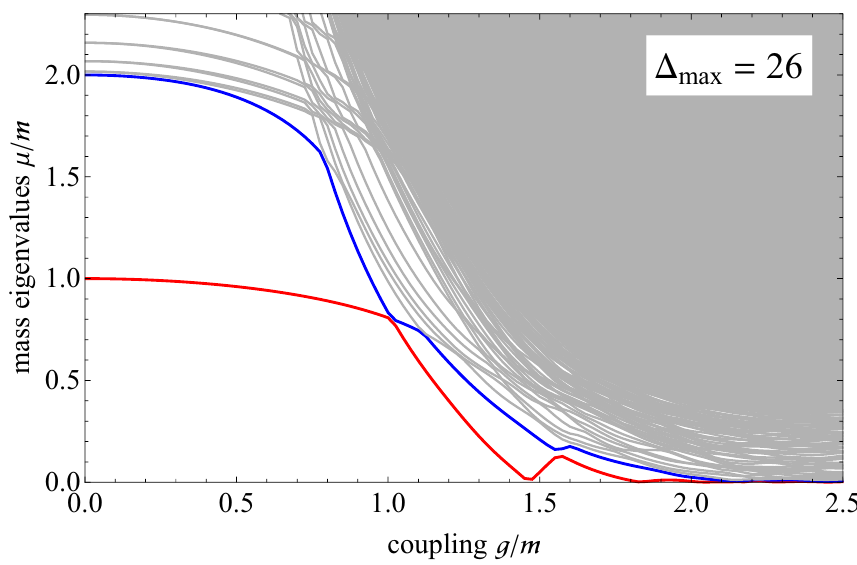
Figure 3 . Mass eigenvalues of the truncated Hamiltonian Q 2 as a function of the coupling g . + We truncate the basis at ∆ max = 26, which includes 40824 states. Each mass eigenvalue is exactly 2-fold degenerate due to supersymmetry. We highlight the lowest two mass eigenvalues at each g with red and blue solid curves. The rest of the eigenvalues are gray solid curves. The higher states become very dense and their curves fill the upper right